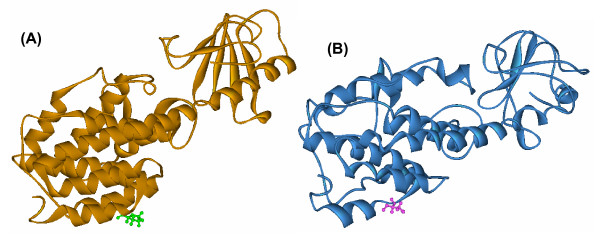
Wild and mutant protein structure of Mce1A. Structure of (A) wild (orange ribbon) and (B) Pro359Ser mutant (blue ribbon) proteins showing Pro359 (green) in wild protein and Ser359 (pink) in the mutant protein represented in ball and stick. The figure was prepared using Discovery studio 2.5 (DS Modeling 2.5, Accelrys Inc.: San Diego, CA).